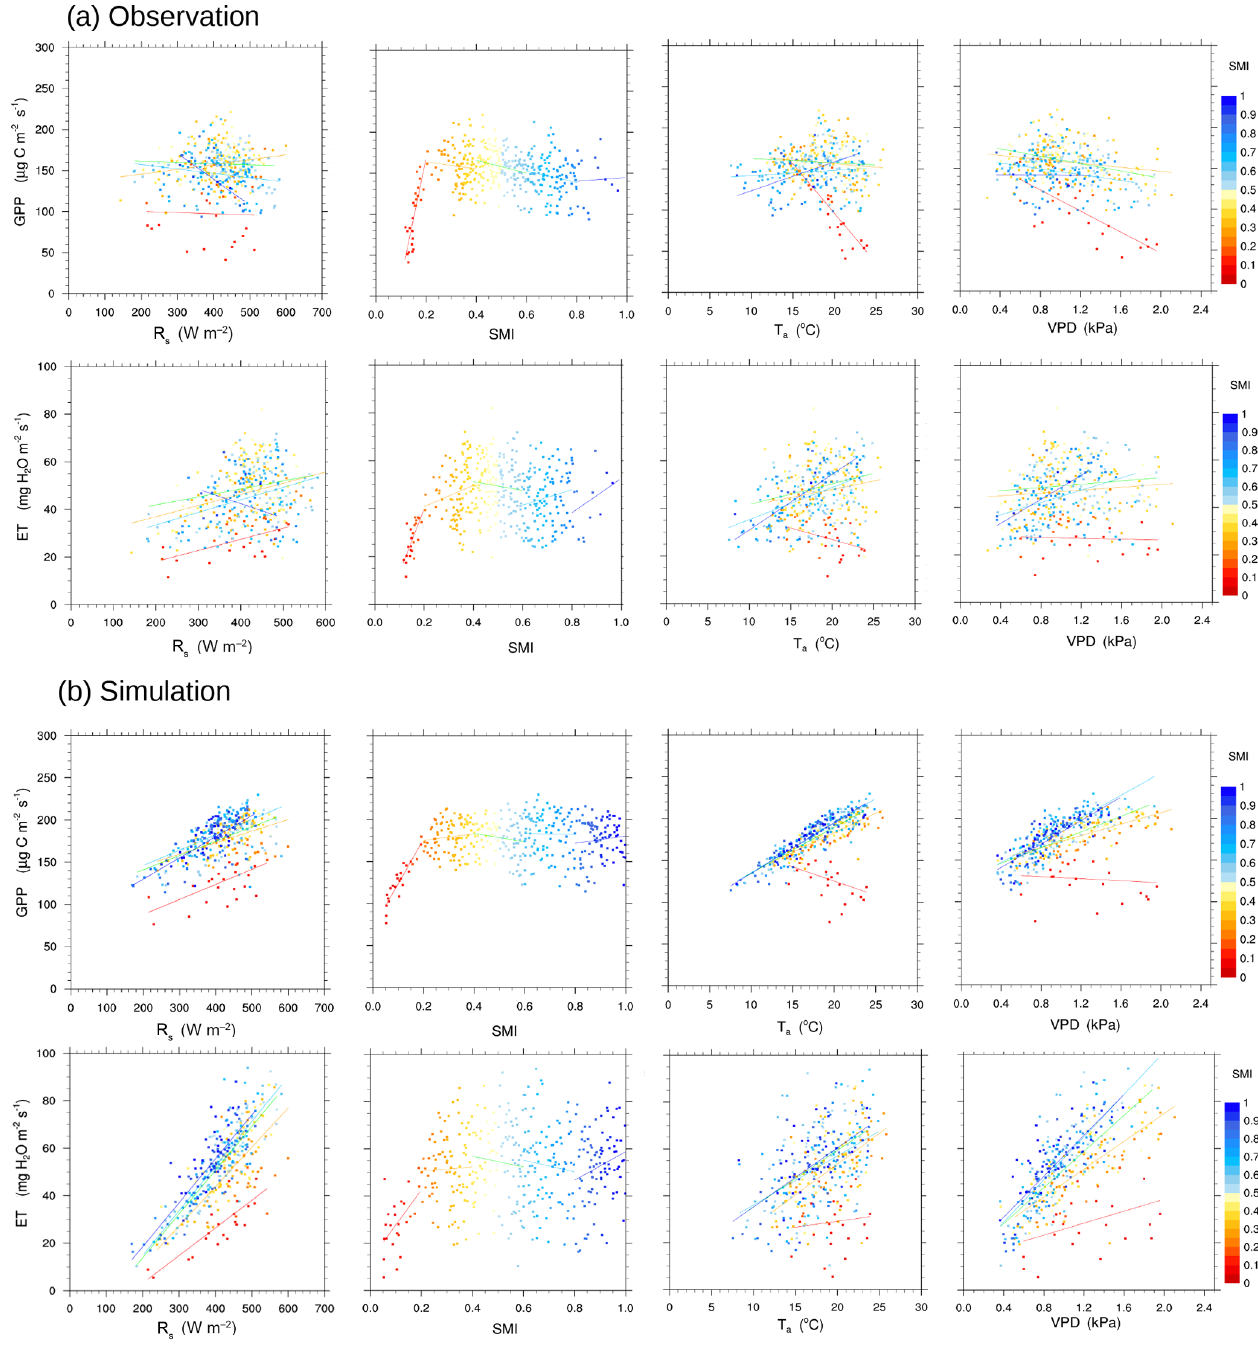
Figure 3. Response of daytime mean gross primary production (GPP in µgCm − 2 s − 1 ) and evapotranspiration (ET in mg H 2 O m − 2 s − 1 ) to daytime mean incoming shortwave radiation ( R s ), daytime mean air temperature ( T a ), daytime mean vapour pressure deficit (VPD), and daily mean soil moisture index (SMI) at Hyytiälä, categorized by daily mean soil moisture index (SMI) in the summer months (June, July, August) of the 11-year study period (from 1999 to 2009) from (a) observation and (b) the JSBACH simulation. The regression lines are fitted for the five SMI groups (very dry, 0 ≤ SMI < 0 . 2; moderate dry, 0 . 2 ≤ SMI < 0 . 4; mid-range, 0 . 4 ≤ SMI < 0 . 6; moderate wet, 0 . 6 ≤ SMI < 0 . 8; and very wet, 0 . 8 ≤ SMI <